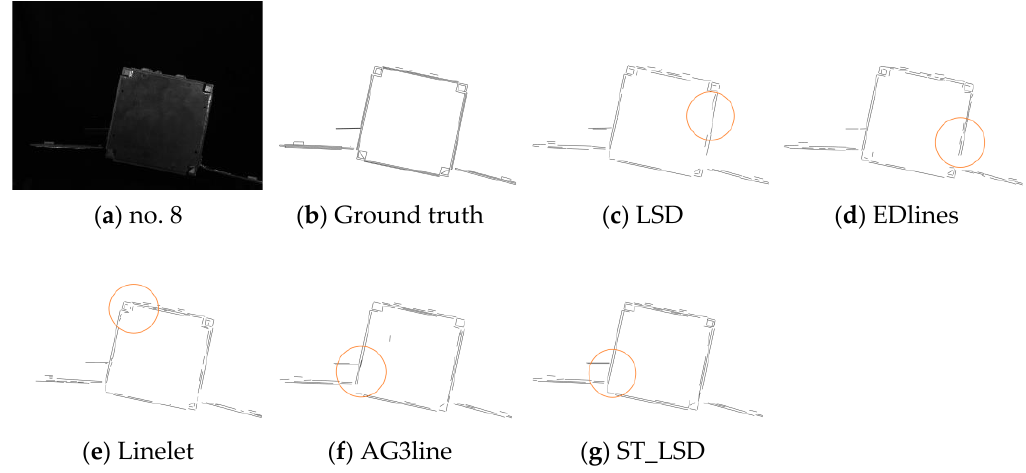
Figure 13. Line segment detection result on image no. 8 of the dataset.